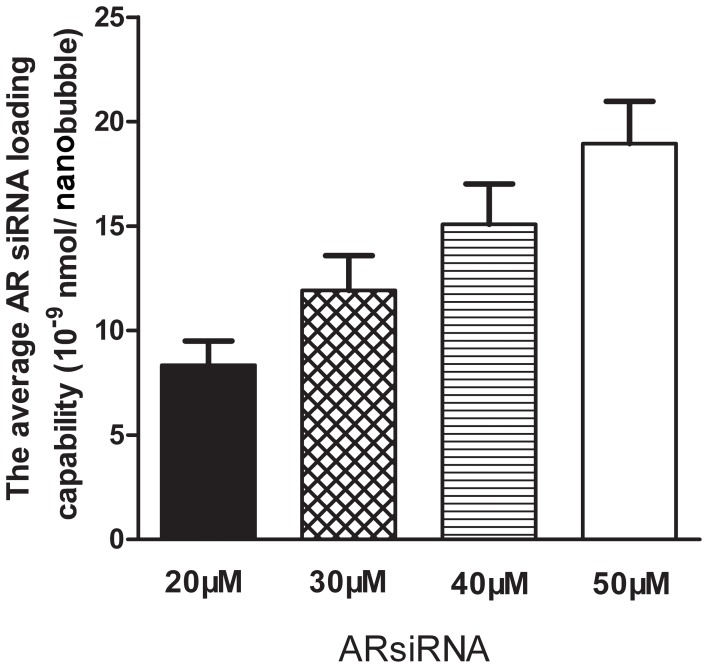
The average AR siRNA loading capacity of PLL nanobubbles varied in a dose-dependent manner.